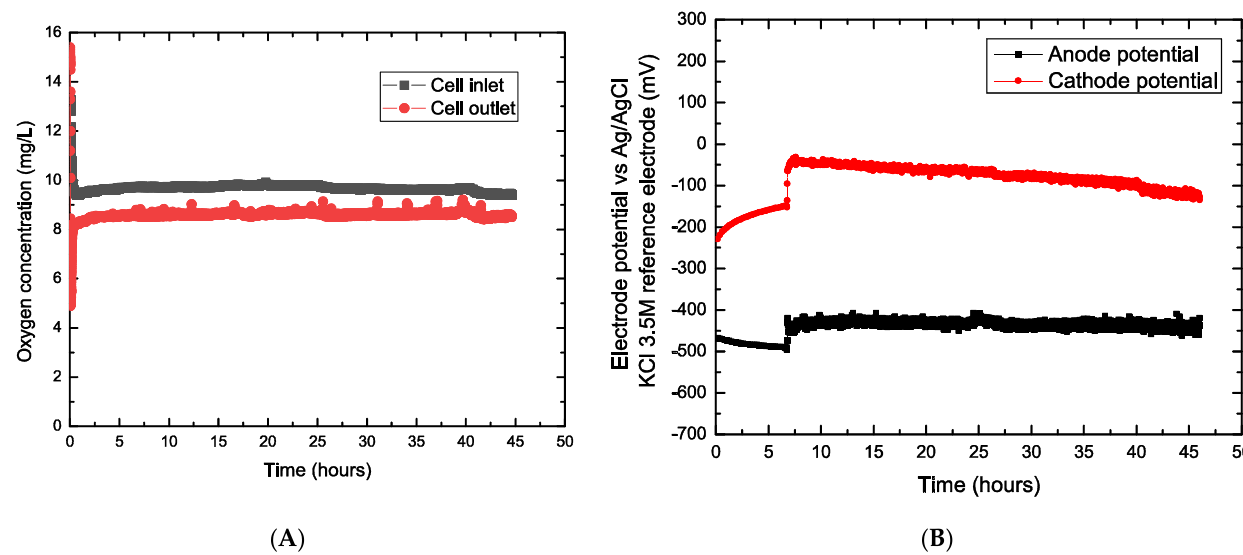
Figure 4. ( A ) Inlet and outlet oxygen concentration vs. time in the cathodic chamber ( B ) Cathode and anode potential vs. time during desalination. NOTE: Experimental data from ( A , B ) were registered simultaneously.